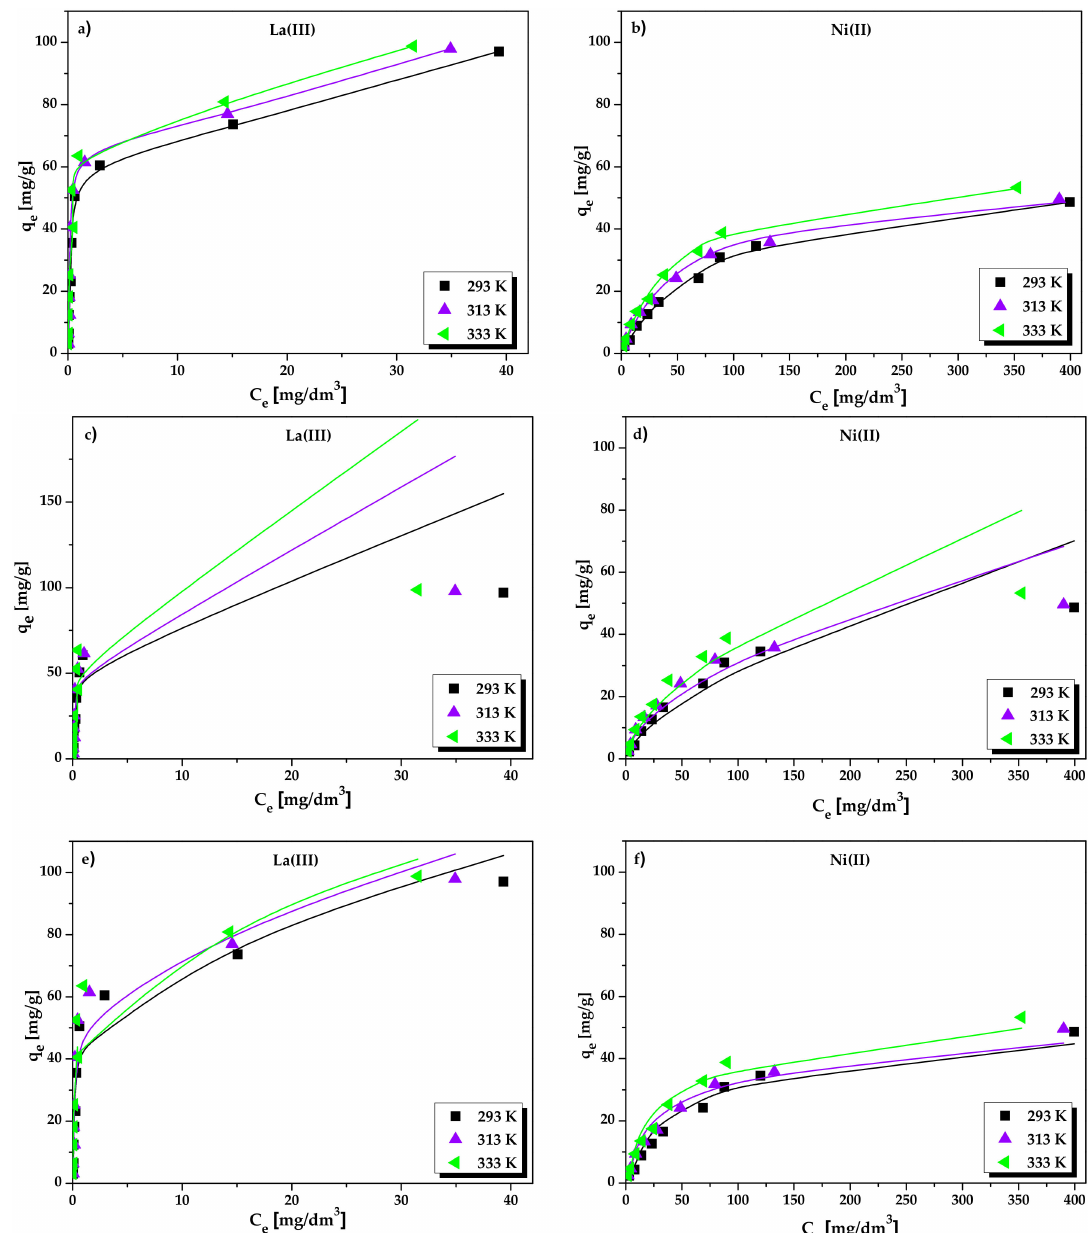
Figure 9. ( a , b ) Langmuir, ( c , d ) Freundlich, and ( e , f ) Temkin plots for the La(III) and Ni(II) ions sorption on Lewatit Monoplus SP112 at di ff erent temperatures. The symbols stand for the experimental data and the lines stand for the fitting by Langmuir, Freundlich and Temkin isotherm models. For the La(III) ions sorption, the theoretical maximum monolayer adsorption capacities are obtained to be 93.21, 94.61, and 95.34 mg / g at 293, 313 and 333 K, respectively. In the case of Ni(II) ions, the q m values were equal to 55.30, 59.17, and 60.81 mg / g at 293, 313 and 333 K, respectively. The calculated experimental adsorption capacities ( q exp ) were consistent with the q m values. The isotherm results indicate that the monolayer adsorption of La(III) and Ni(II) on the Lewatit Monoplus SP112 surface dominates the process. Additionally, the metal binding is treated as a chemical reaction between the metal ions and empty sites of ion exchanger. The Langmuir constant ( K L ) indicates the extent of interactions between the metal ions and the ion exchanger surface. If the K L values are relatively larger, this indicates that there are strong interactions between the metal ions and the adsorbent while smaller K L values indicate weaker interactions. As shown in Table 3, the higher K L values were obtained